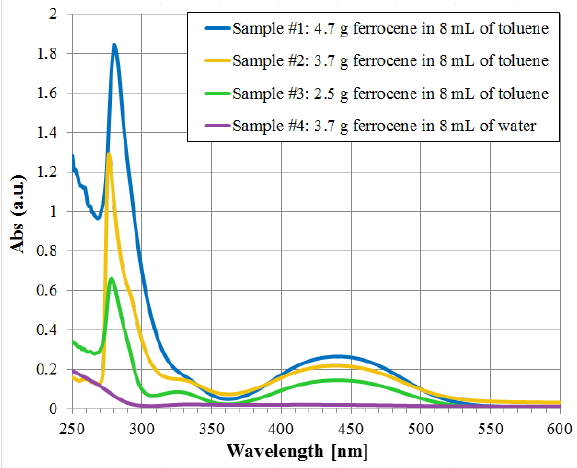
Figure 3: Absorption spectra of ferrocene diluited in toluene or water, varying the ferrocene concentration in 8 mL of solvent.